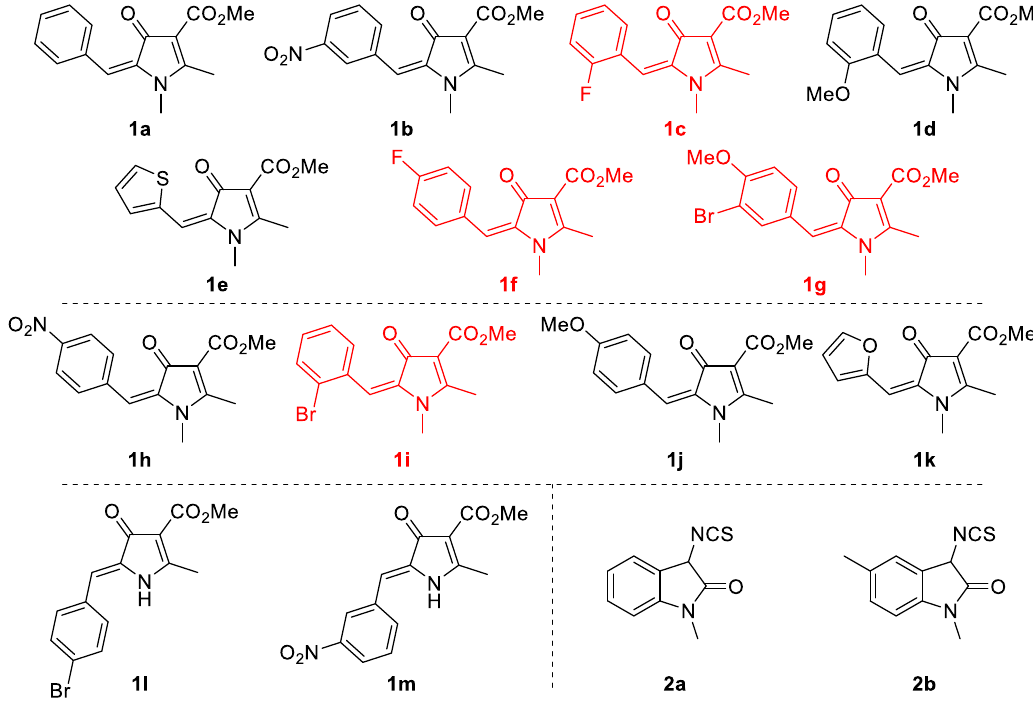
Figure 2. Selected 5-arylidene-2-methyl-4-oxo-4,5-dihydro-1 H -pyrrole-3-carboxylates 1 and 3-isothiocyanato oxindoles 2 ; color red—novel reported pyrrolones 1 .